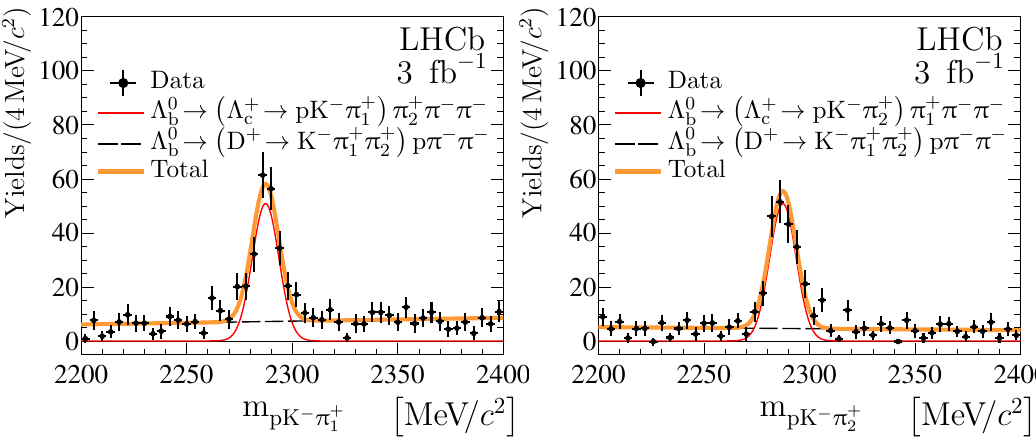
mass spectra from the Λ 0 1 , 2